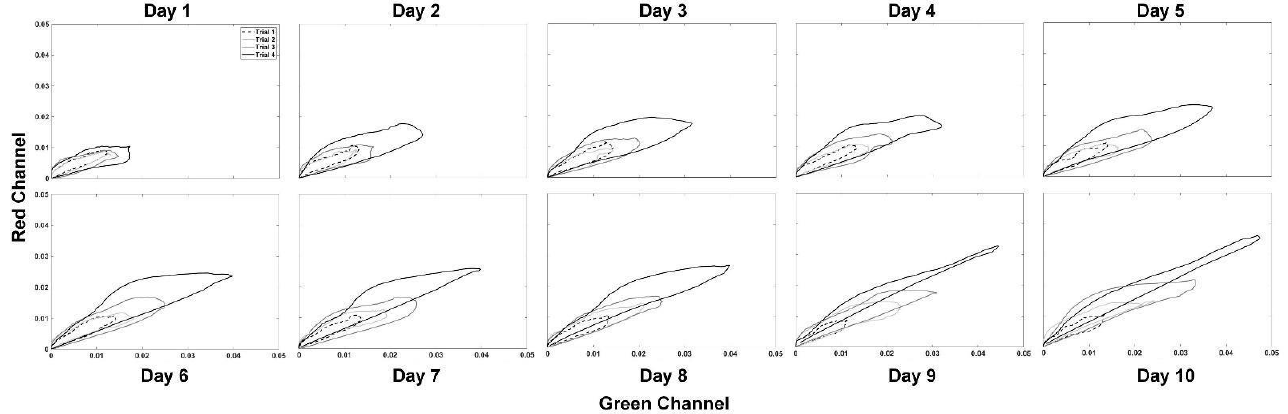
Figure 8. Stacked red versus green color plots (both lasers) using color channels generated from initial images and their histogram profiles (Figure 4). From darkest to lightest: dashed black is trial 1 (control), light gray is trial 2, medium gray is trial 3, and dark gray is trial 4. Profiles were plotted for each day to compare each trial’s potential separation from the control.